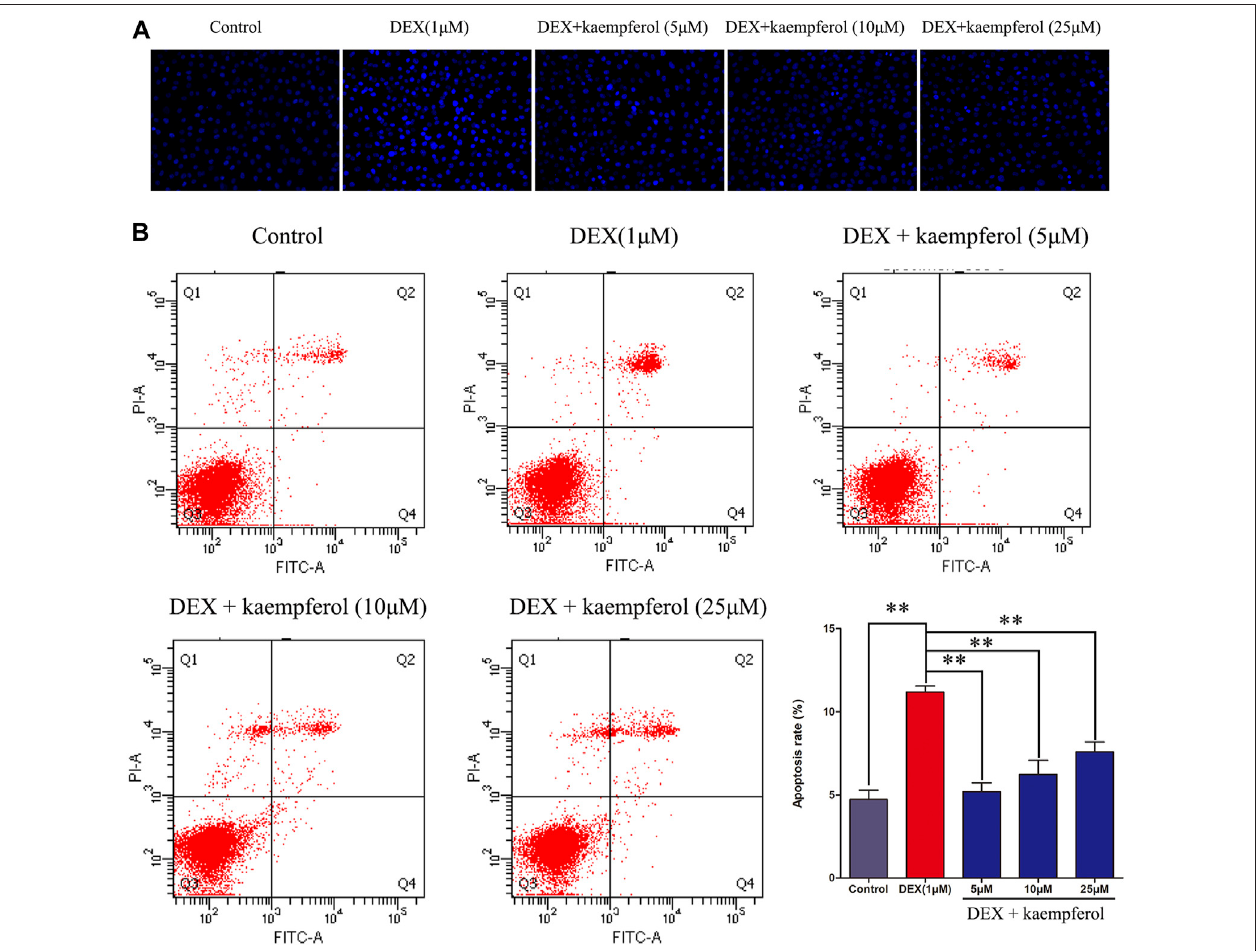
FIGURE3| KaempferolalleviatedcellapoptosisinducedbyDEXinMC3T3-E1cells.Cellswereco-culturedwithkaempferol(5,10,and25 μ M)andDEX(1 μ M)for 3 days. (A) The cells were stained with Hoechst 33342 and observed under fl uorescence microscope; (B) Cells were stained with PI and annexin V-FITC to evaluate apoptosis by fl ow cytometry. * p < 0.05, ** p <